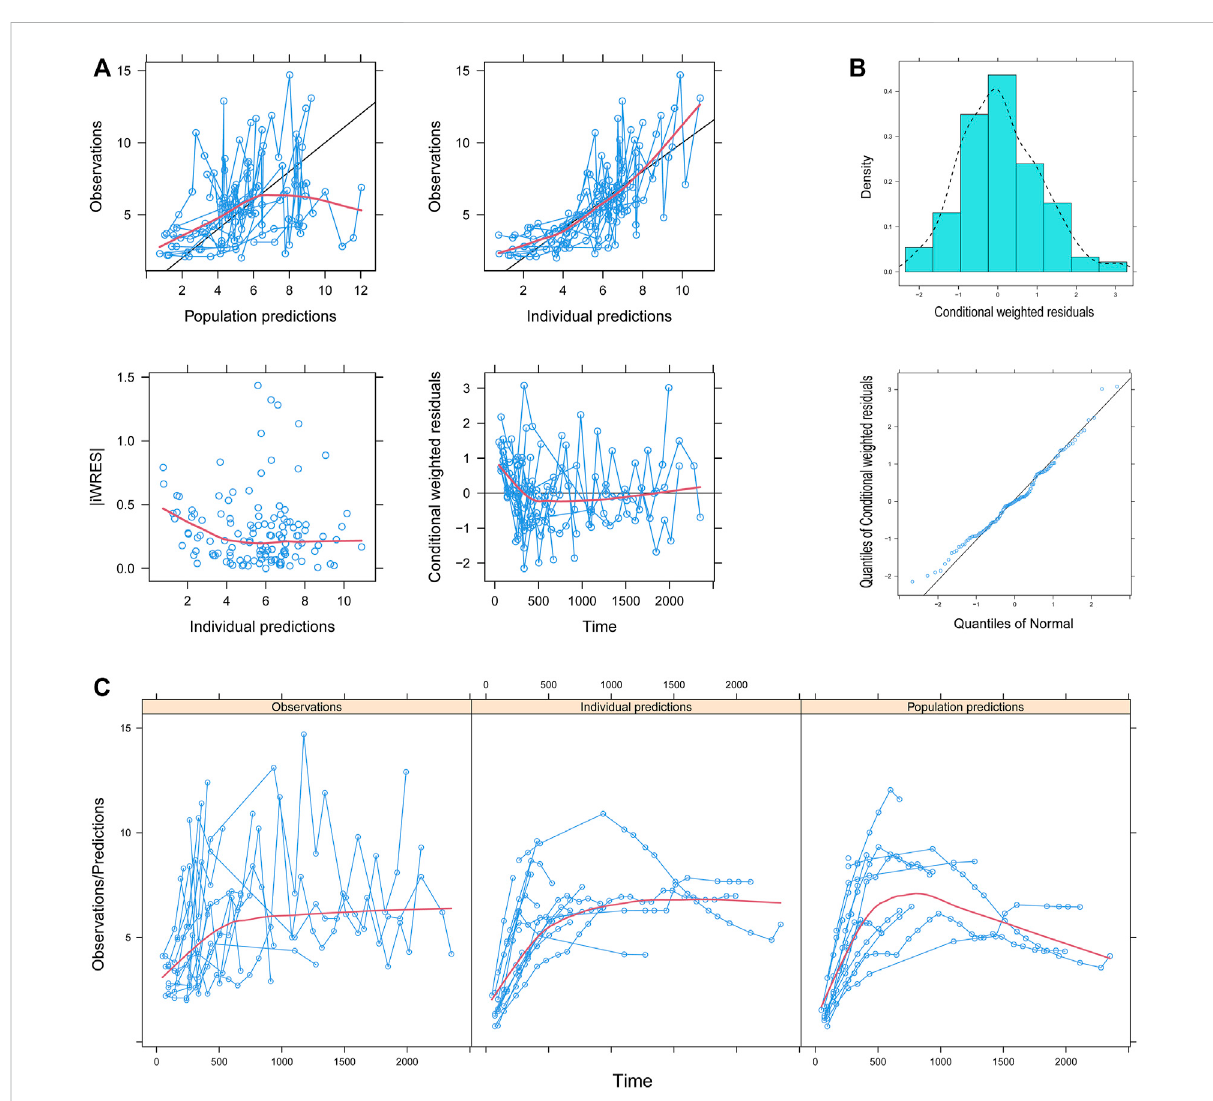
FIGURE 1 Model evaluation. (A) Goodness-of- fi t plots of the model, (B) distribution of weighted residuals for the model, and (C) observation/individual predictions/population predictions vs. time. │ iWRES │ , the absolute value of weighted residuals of the